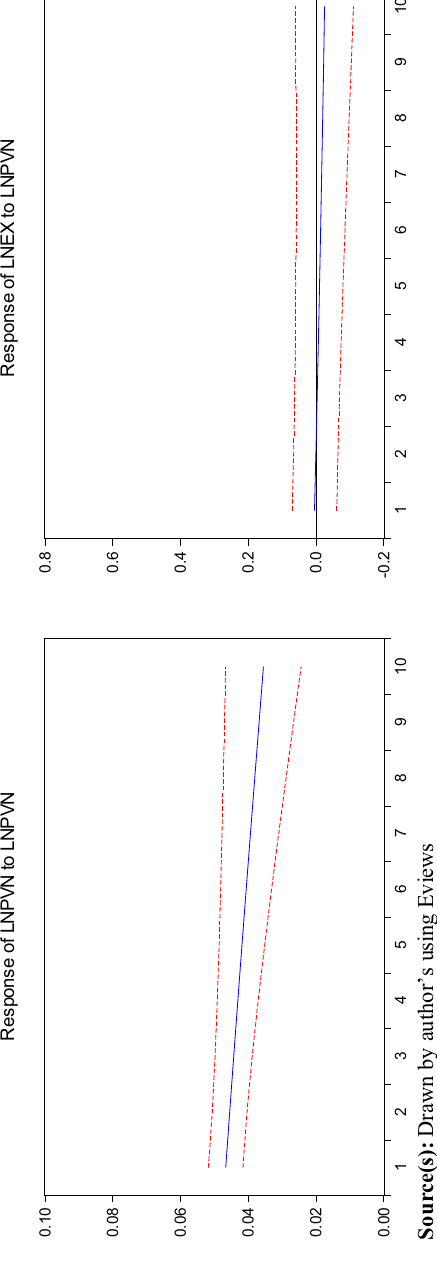
Figure 4. Response to Cholesky one S.D. innovation ±